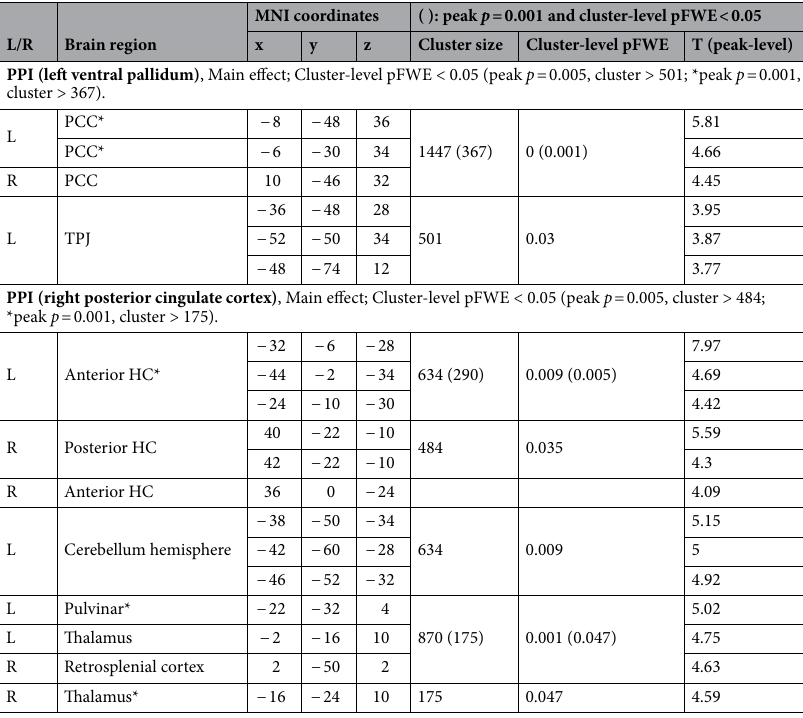
Table 3. Results of the PPI analysis with each of the left ventral pallidum and the right posterior cingulate cortex as a seed.